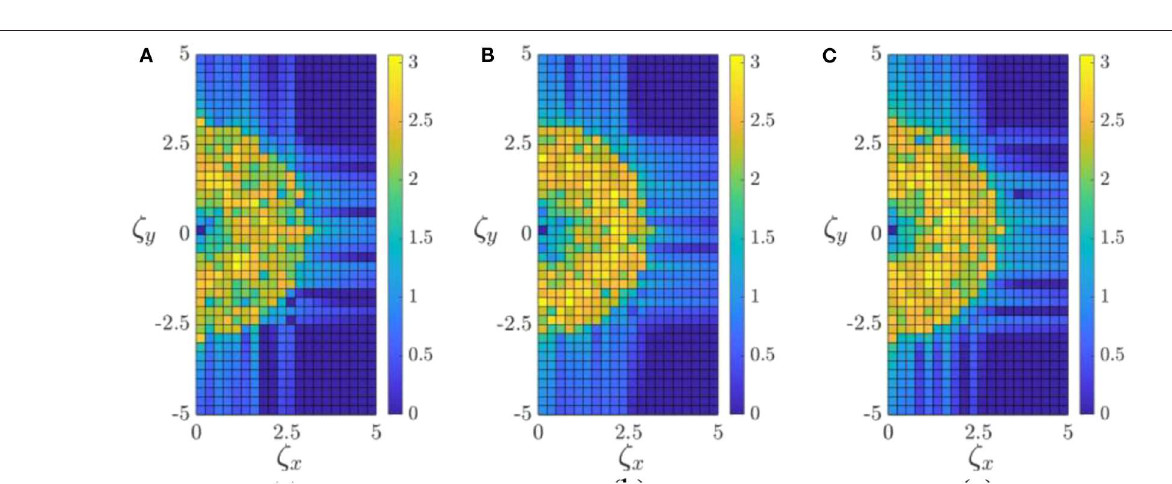
FIGURE 5 | Fourier transform of g ( x , y ) from Figures 4A–C